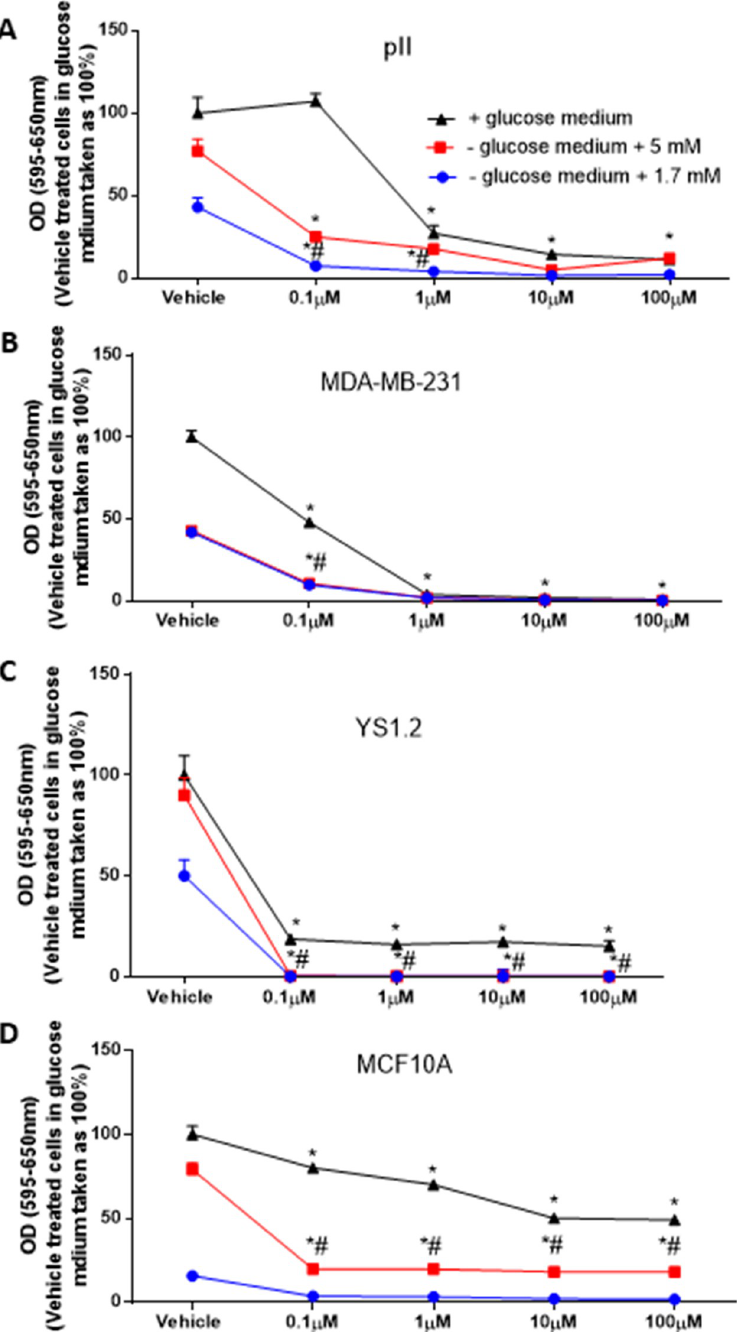
Fig 8. Effect of glucose depletion on the anti-proliferative effects of paclitaxel in breast cancer cell lines. The effect of paclitaxel on cell proliferation upon culture in +glucose medium (black line, taken as 100%) or -glucose medium plus 5 mM (red line), or 1.7 mM glucose (blue line) was determined at day 4 using the MTT assay. Histobars represent means ± SEM of at least 3 independent determinations. � denotes significant difference from cells treated with vehicle (normal saline), with p <